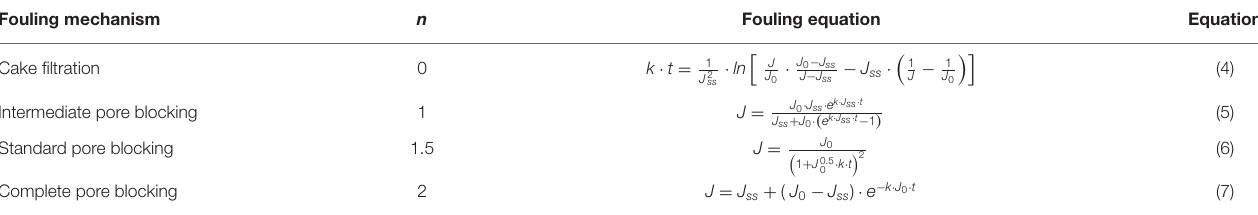
TABLE 1 | Fouling models for cross-flow filtration, where J = permeate flux, J ss = steady-state permeate flux, J 0 = initial permeate flux, and k is a model parameter. Fouling mechanism